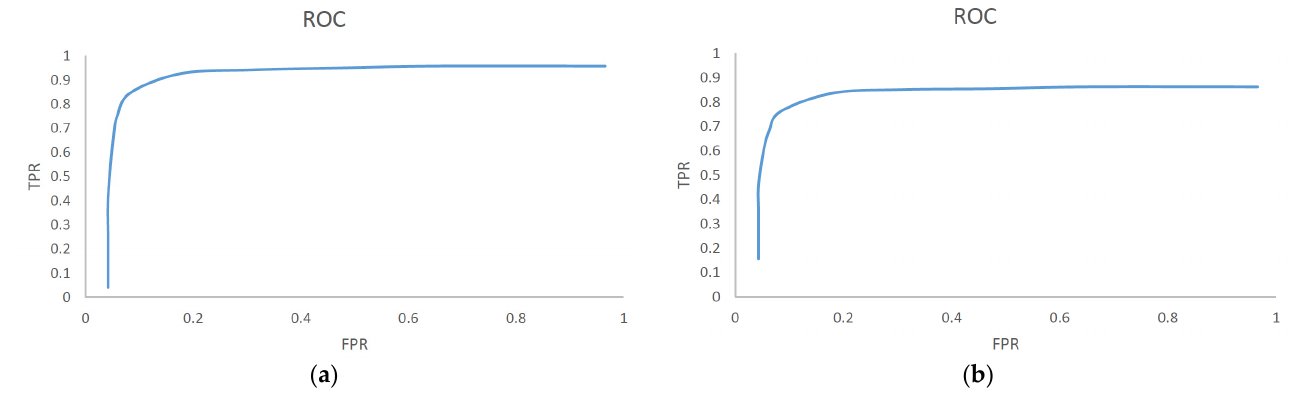
Figure 4. ROC graph of the ( a ) UNet model and ( b ) FCN-8 model.